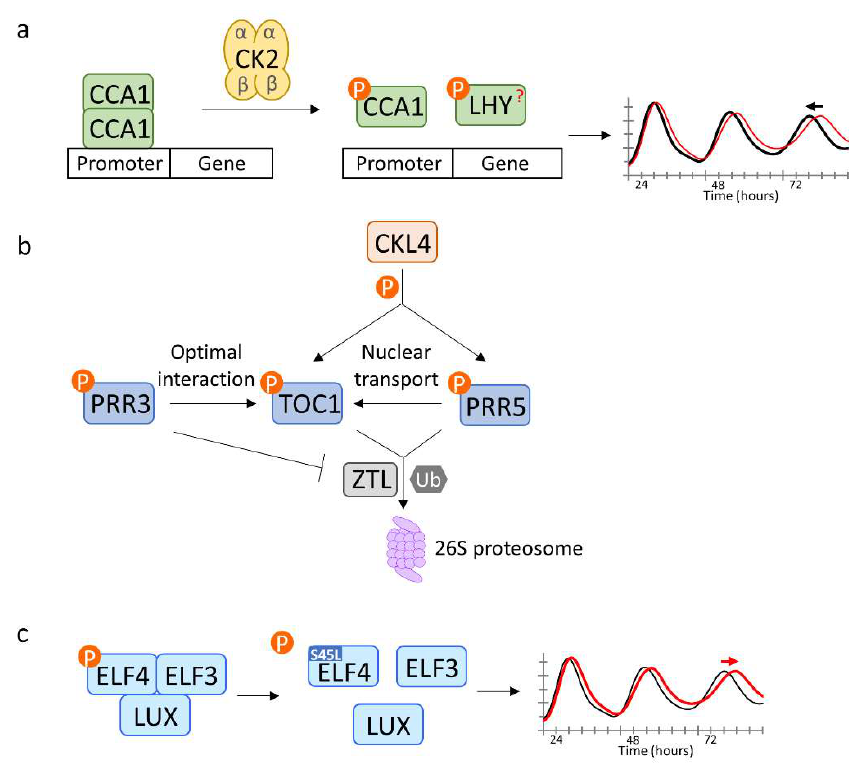
Figure 1. Phosphorylation of clock proteins modulates their function in regulating circadian rhythms. ( a ) CK2 phosphorylates CCA1 and interferes with its binding to target promoters, leading to reduced transcriptional activity of CCA1 and a shortened circadian period (LHY? indicates CK2 phosphorylates LHY in vitro, but in vivo evidence has not yet been reported). ( b ) CKL4 phosphorylates TOC1 and PRR5. Phosphorylation of TOC1 and PRR5 enhances their interaction with ZTL and subsequent proteasomal degradation. Phosphorylation also stabilizes TOC1 by PRR5-mediated nuclear sequestration and by competitive interaction with PRR3 which protects TOC1 from ZTL-targeted proteasomal degradation. It is not known whether CKL4-mediated phosphorylation is responsible for the interaction and/or transport features of TOC1 and PRR5. ( c ) Mutation of the ELF4 phosphorylation site diminishes interaction with ELF3 and lengthens circadian period.